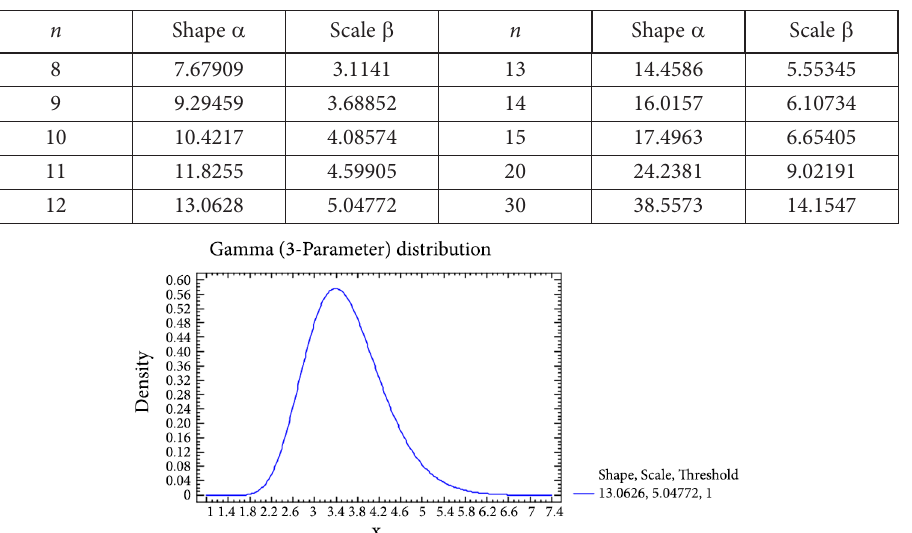
Figure 6. Sample geometric dispersion distribution (n =